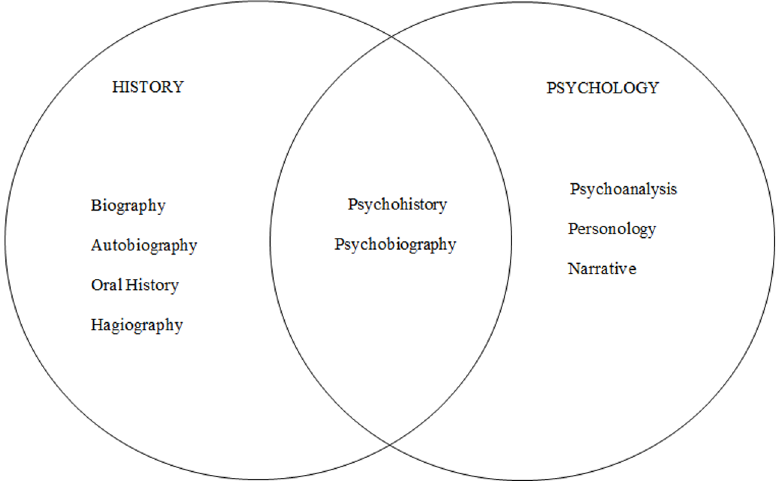
Figure 1. Locating psychobiography at the intersection of history and